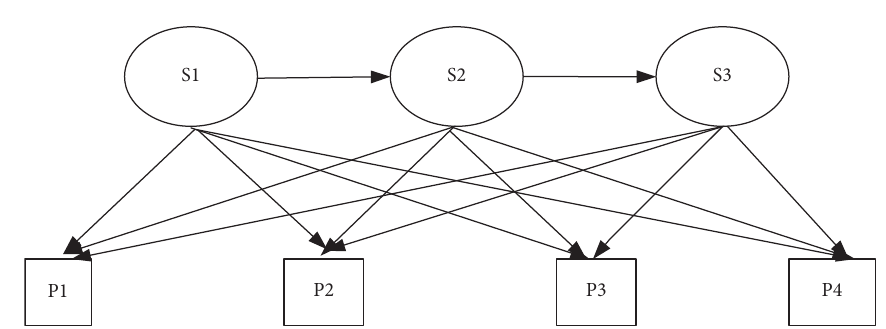
Figure 2: Hidden Markov probability parameters.